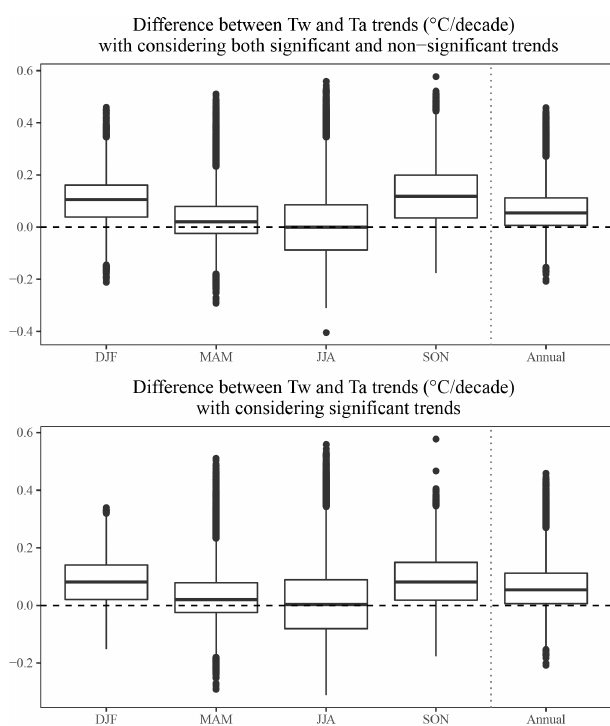
Figure 5. Difference between T w and T a trends at each reach in ◦ C per decade for all 52278